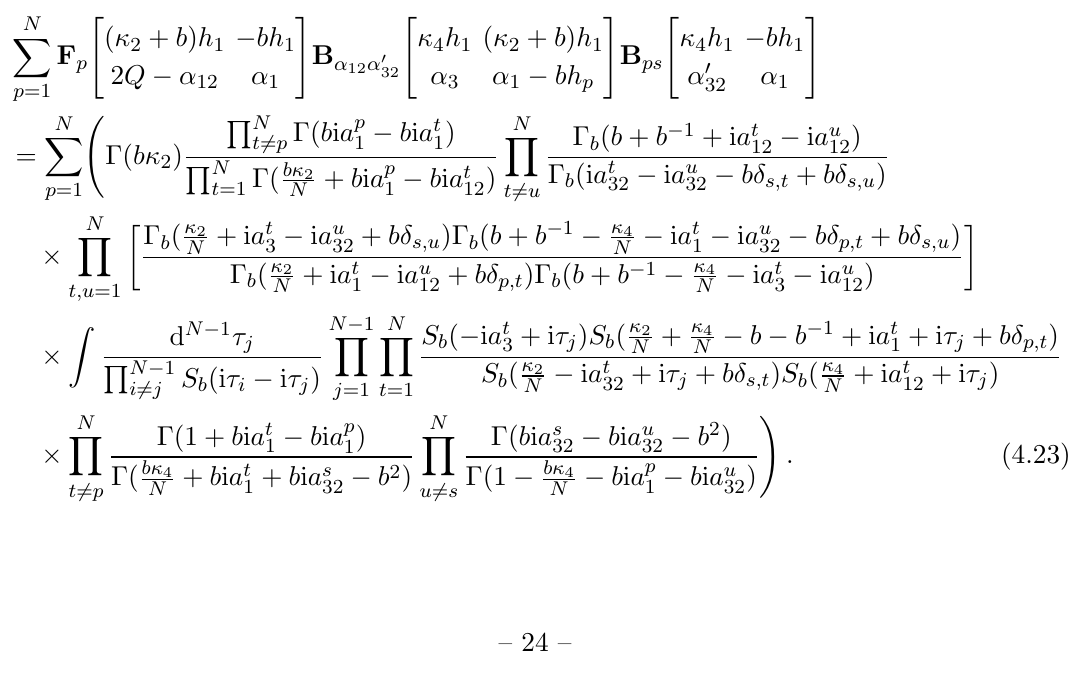
and a semi-degenerate, 5 $ 3 is a known braiding of b V (cid:0) bh 1